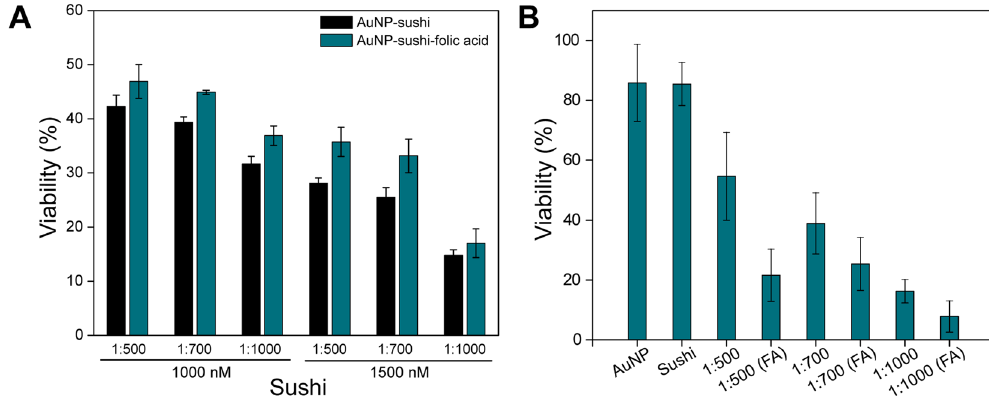
Figure 5. Comparison of antimicrobial activity against S. typhi for AuNP-sushi with and without FA- functionalization. Percent viability by colony count of bacteria before ( A ) and after ( B ) internalization inside HeLa cells. (One way ANOVA, *** P <